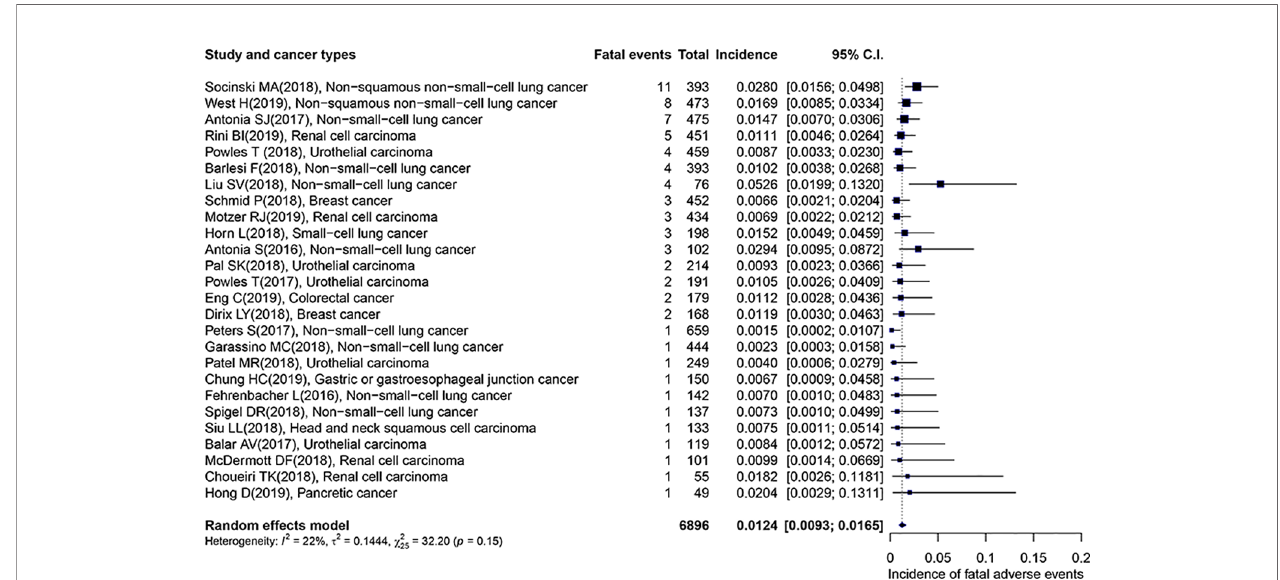
FIGURE 2 | Forest plot of the overall incidence of fatal adverse events associated with PD-L1